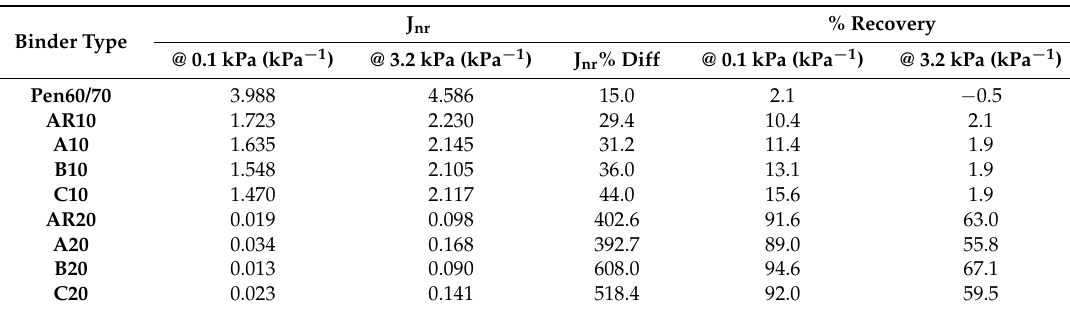
Table 4. MSCR test Table 4. MSCR test results.